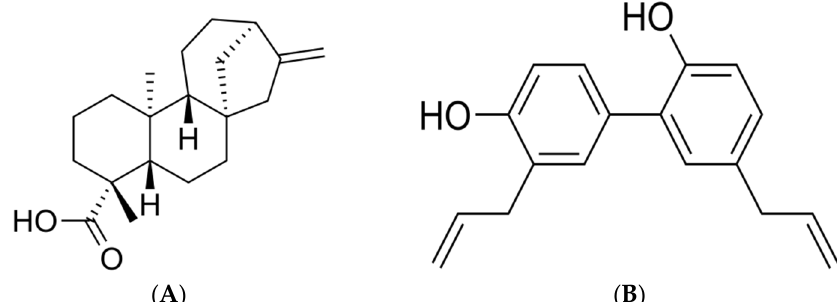
Figure 1. Structures of the investigated compound and internal standard (IS). ( A ) Kaurenoic acid (KAU), and ( B ) IS.